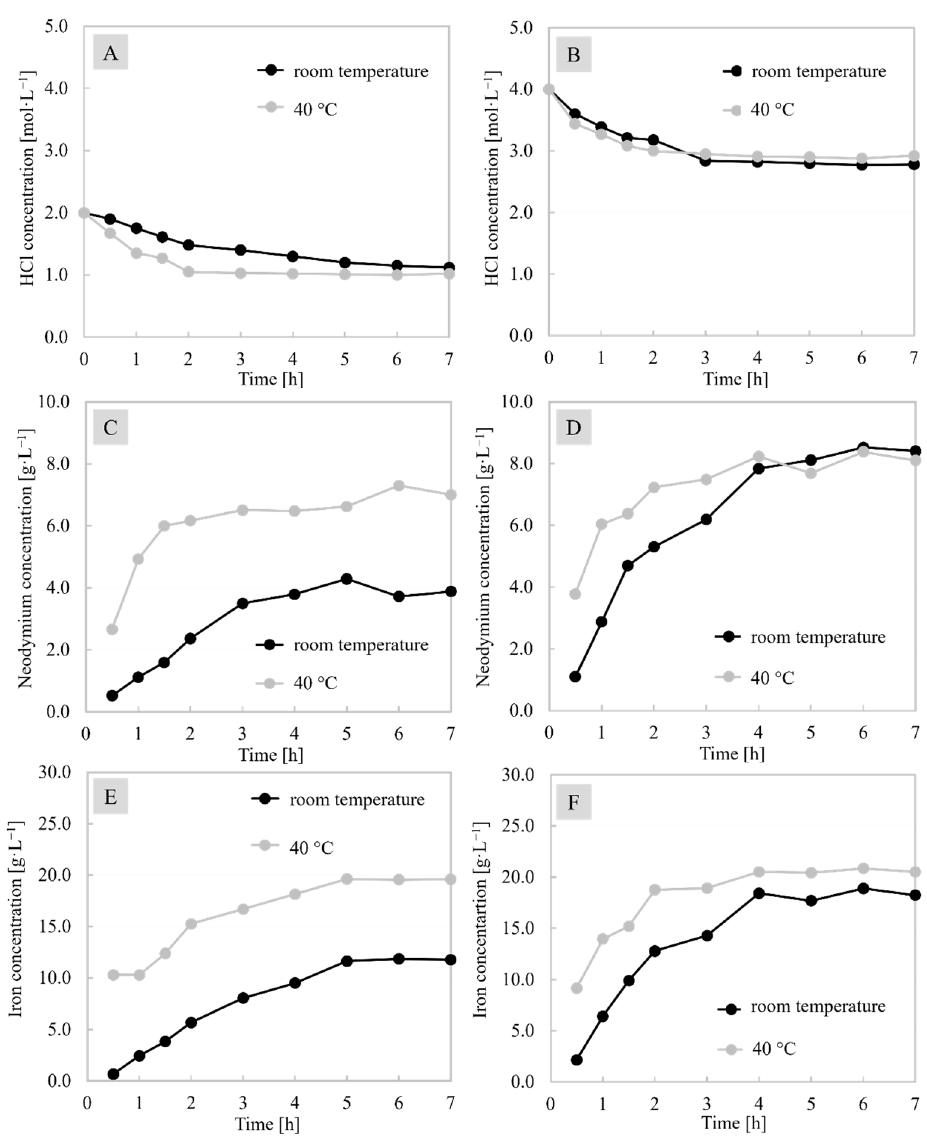
Figure 7. Leaching of the whole (non-demagnetized) NdFeB magnets in 2 M HCl solution (left side) and 4 M HCl solution (right side). Different figures show the dependence between leaching time and the concentration of HCl ( A , B ), neodymium ( C , D ) and iron ( E , F ).